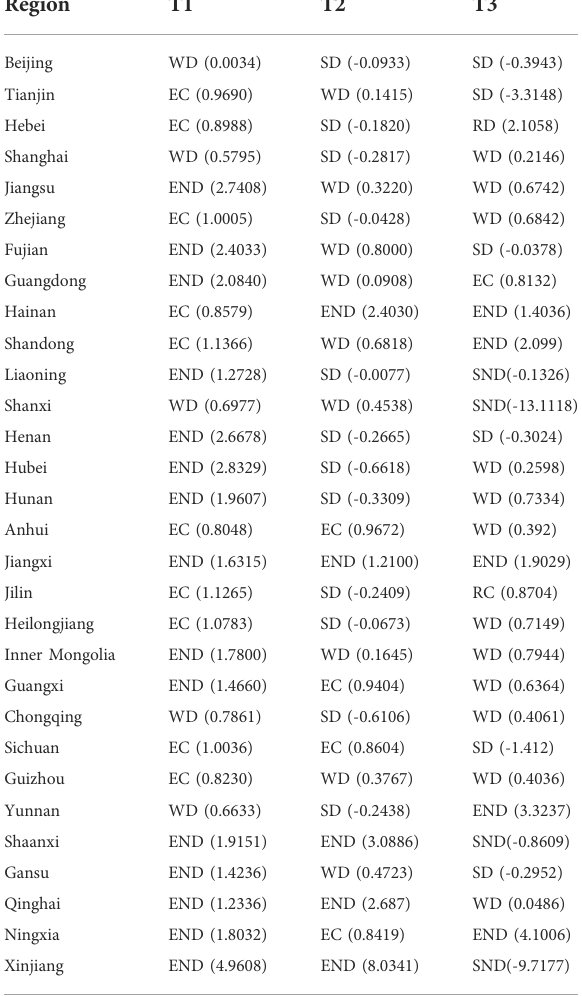
TABLE 6 State of decoupling between ILU and carbon